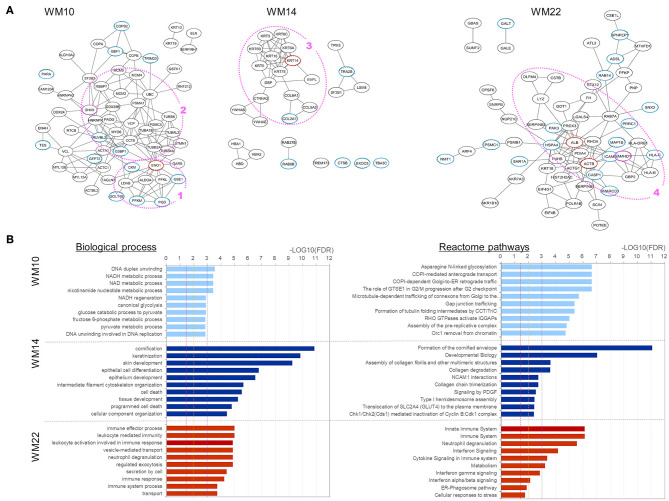
Analysis results for three protein modules (WM10, WM14, and WM22) that overlap with proteins uniquely and upregulated under the L858R mutation, respectively. (A) Protein interaction networks for the three WGCNA modules. Dotted circle nodes in blue and red represent eigen-proteins and hub proteins, respectively, for each module. (B) Pathway enrichment analysis using Go Biological Process and Reactome pathway databases for the three protein modules. The vertical axis shows the pathway names, and the bars on the horizontal axis represent the –log10 (p-value) of the corresponding pathway. The different colors of the bars are following the corresponding modules. Dashed lines in red, orange, and magenta indicate p-values <0.05, <0.01, and <0.001, respectively.